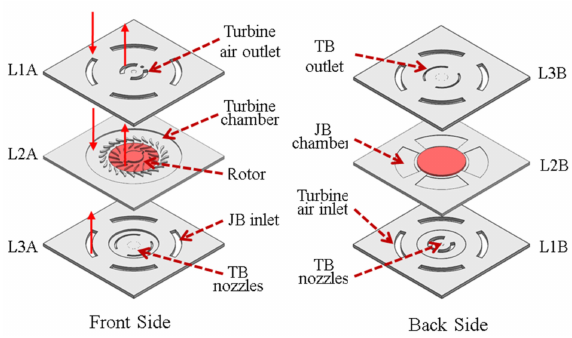
Figure 1. Exploded diagram of the micro air bearing rig.